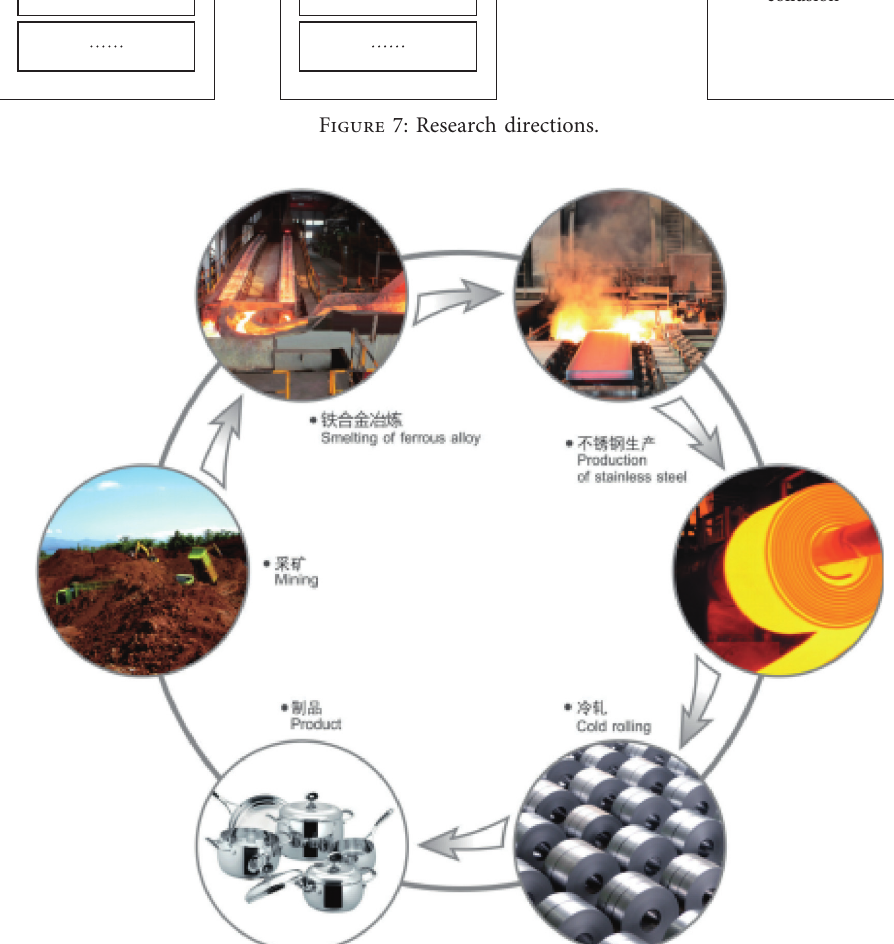
Figure 8: Whole supply chain of Jinguang